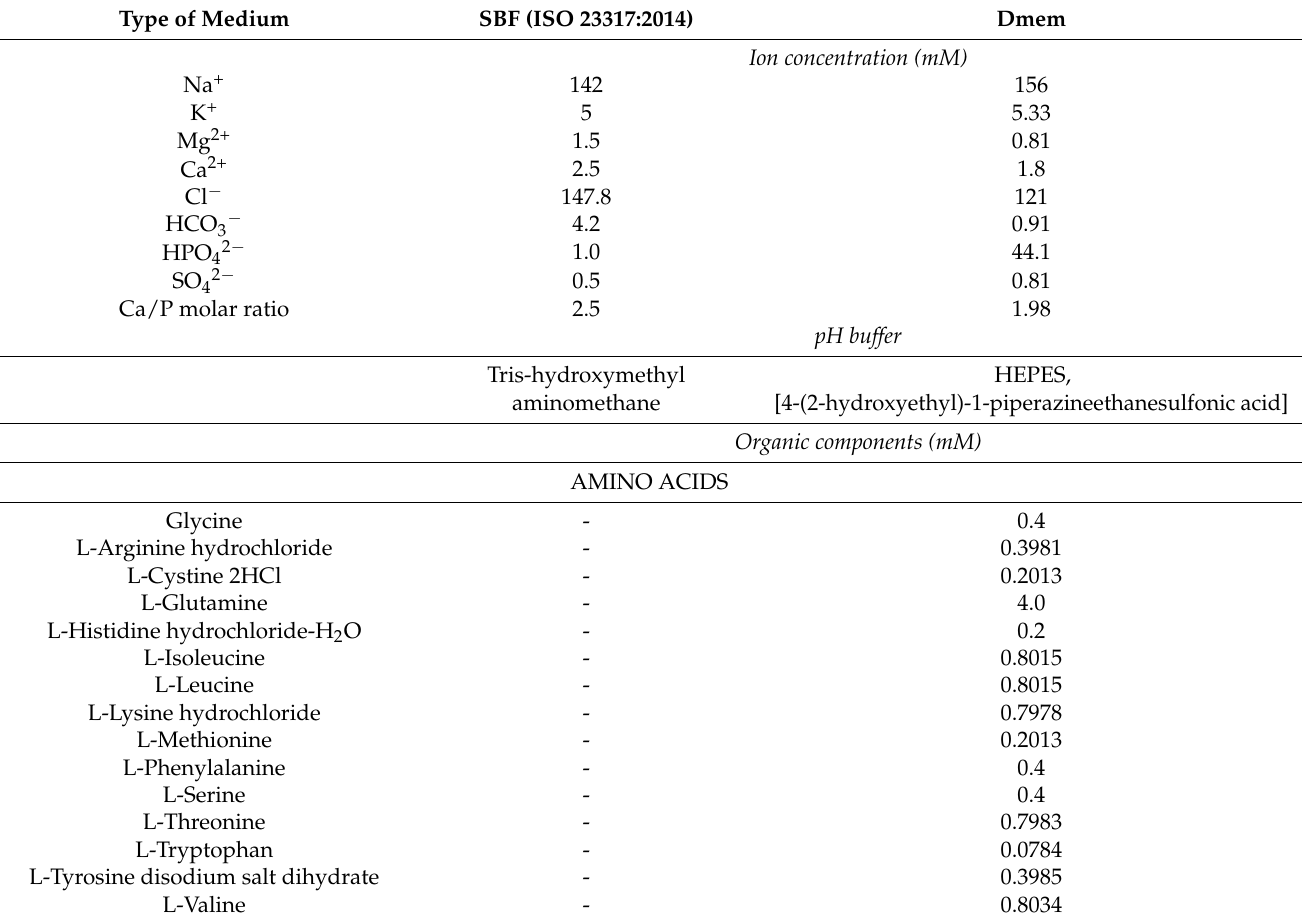
Table 1. Composition of the SBF and DMEM